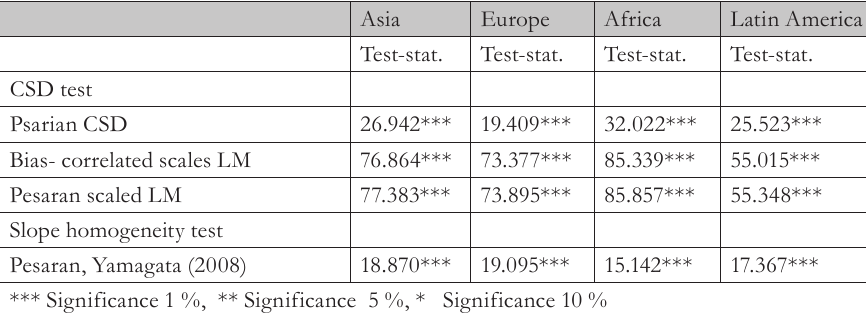
Tab.1 – Cross-sectional dependence (CSD) and slope homogeneity test results. Source: own